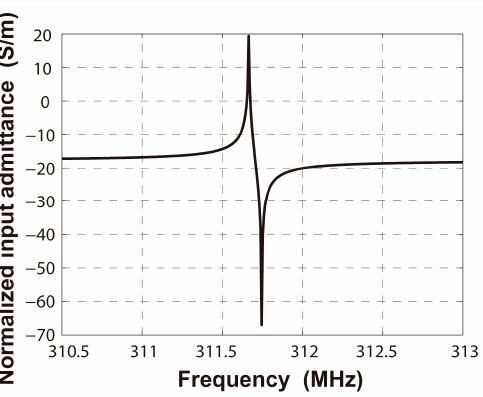
Figure 10. Input admittance of periodic layered IDT on ST-X quartz.